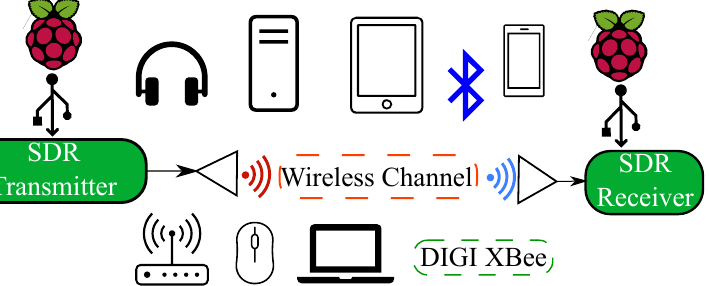
Figure 3. Proposed SDR approach for achieving the desired data strategy for I/Q samples in the ISM RF band between 2.4 and 2.5 GHz.